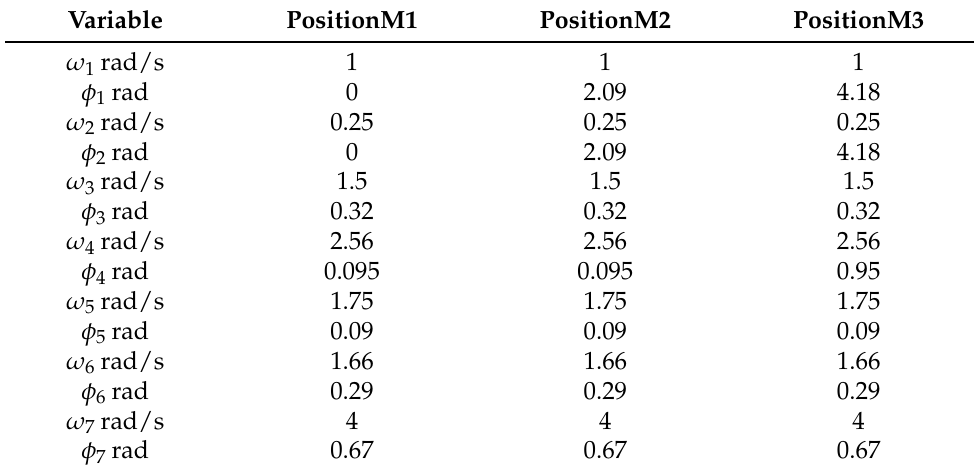
Table 2. Values used for the identification data set